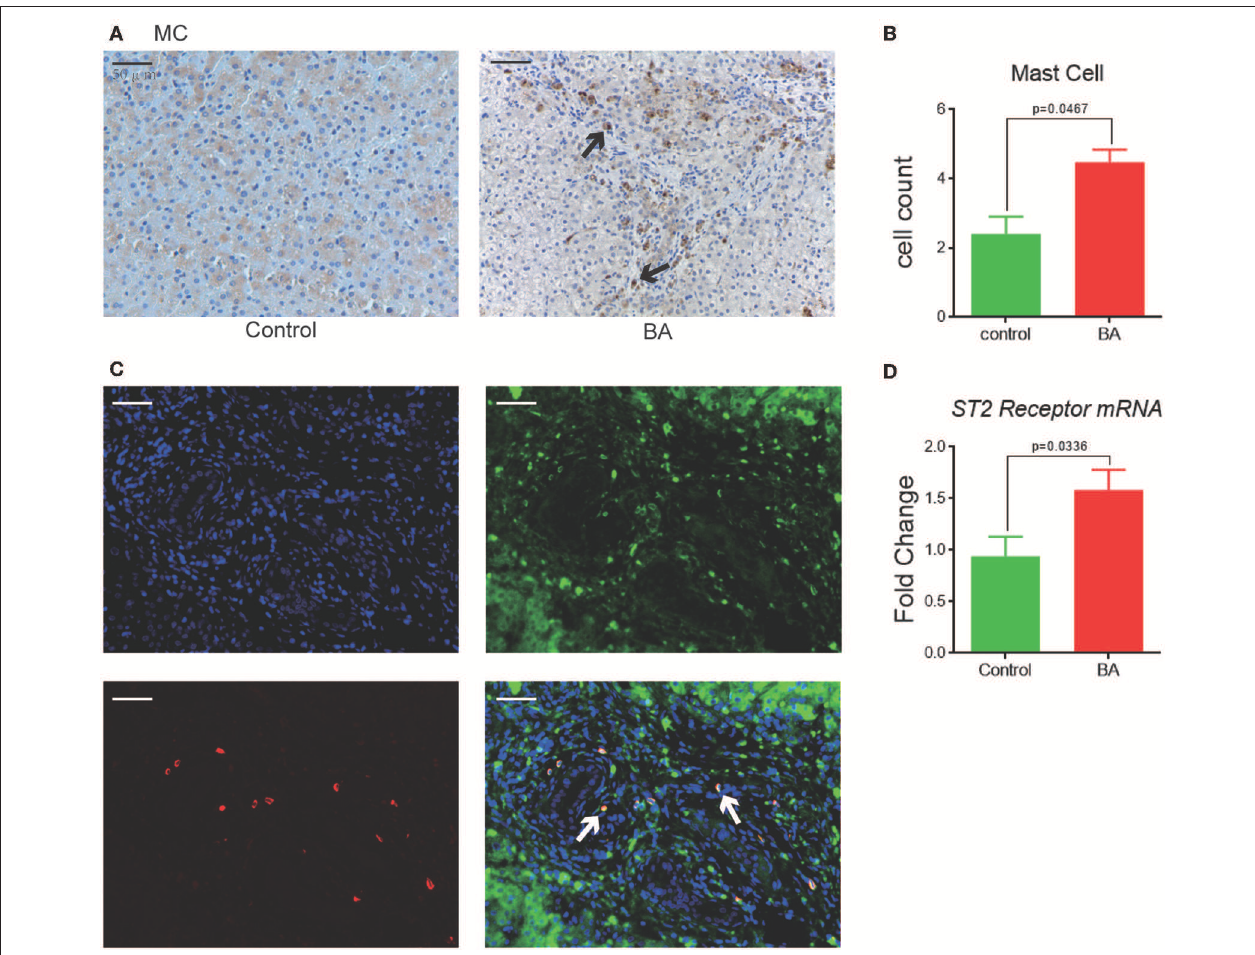
FIGURE 4 | MC expressions and its co-expression with ST2 receptor. (A) MC tryptase expression in control and BA livers, shown as brown positive staining (black arrow). (B) MC quantification in the liver of two groups by cell count. (C) Immunofluorescence of MC tryptase (red), ST2 receptor (green), and DAPI (cell nuclei). Merged figure shows co-localization of MC and ST2 receptor (white arrows). (D) ST2 receptor mRNA expression in control and BA livers.